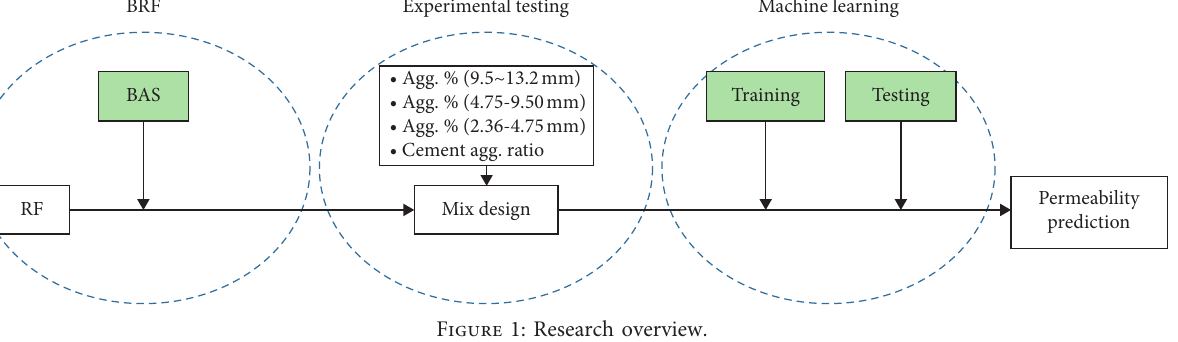
Figure 1: Research overview.